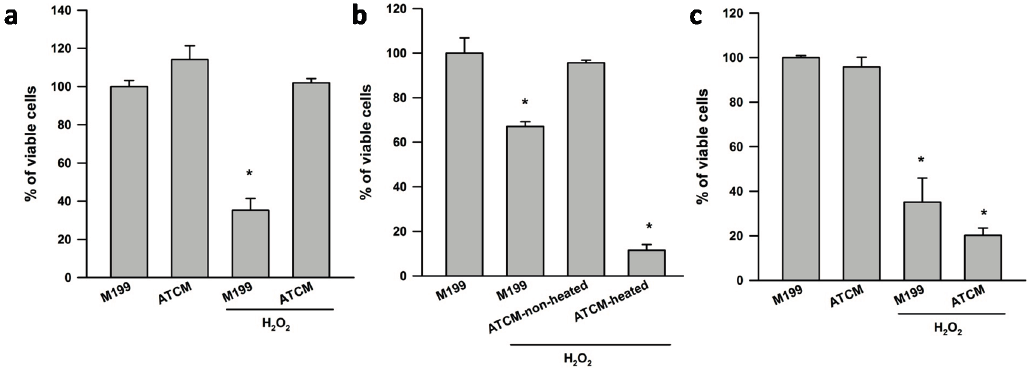
Figure 1. Heat-sensitive factors secreted from human preperitoneal adipose tissue protect against H 2 O 2 induced toxicity in SH-SY5Y neuronal cells. Adipose tissue conditioned media (ATCM) from lean subjects was applied to SH-SY5Y neuronal cells for 24 h in the presence of 800 µM H 2 O 2 . Control cell cultures were treated with M199 media. ( a ) ATCM had no direct effects on SH-SY5Y neuronal cell viability assessed by the MTT assay, but lean ATCM completely reversed H 2 O 2 induced neurotoxicity; ( b ) The neuroprotective effect of lean ATCM was abolished when ATCM was heated at 95 °C for 10 min and ( c ) ATCM from subcutaneous fat of obese subjects demonstrated no effect on H 2 O 2 induced neurotoxicity. Data (mean + S.E.M.) are expressed as % viable cells, where 100% values were obtained from SH-SY5Y cells incubated with fresh M199 only. All cell culture experiments were repeated on two separate passages of cells with ATCM from three different subjects ( n = 6). * p < 0.05 compared to M199